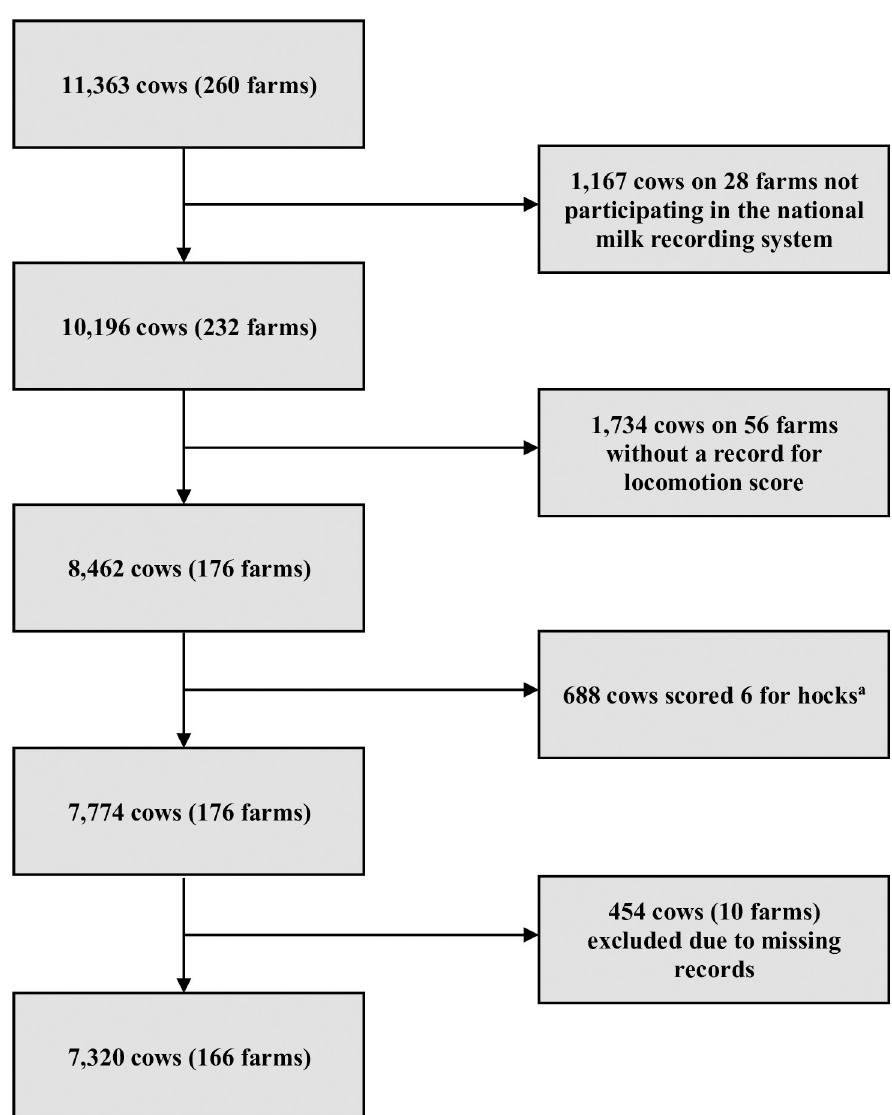
Fig 1. Flow chart displaying the workflow of creating the final data set for modelling from the original raw data. Out of 11,363 cows on 260 farms in the original data set, 28 farms (n cows = 1,167) did not participate in the national milk recording system and were therefore excluded. A further 1,734 cows (n farms = 56) were housed in tie stalls and in 688 cows no assessment of the hock region was possible due to solid plaques of manure on both hocks. Missing records led to the exclusion of 454 cows (n farms = 10). Hence, a total amount of 7,320 cows on 166 farms were included in the current study. This final data set was used for all statistical analyses. n cows : absolute number of cows; n farms : absolute number of farms. a no assessment possible due to solid plaques of manure on both